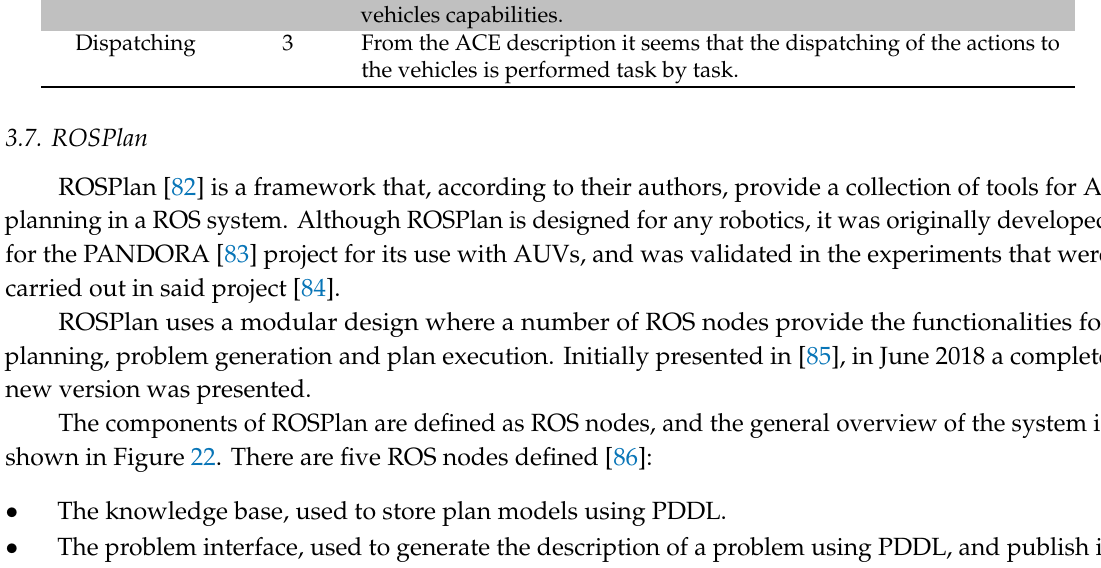
Table 11. TRAC assessment.